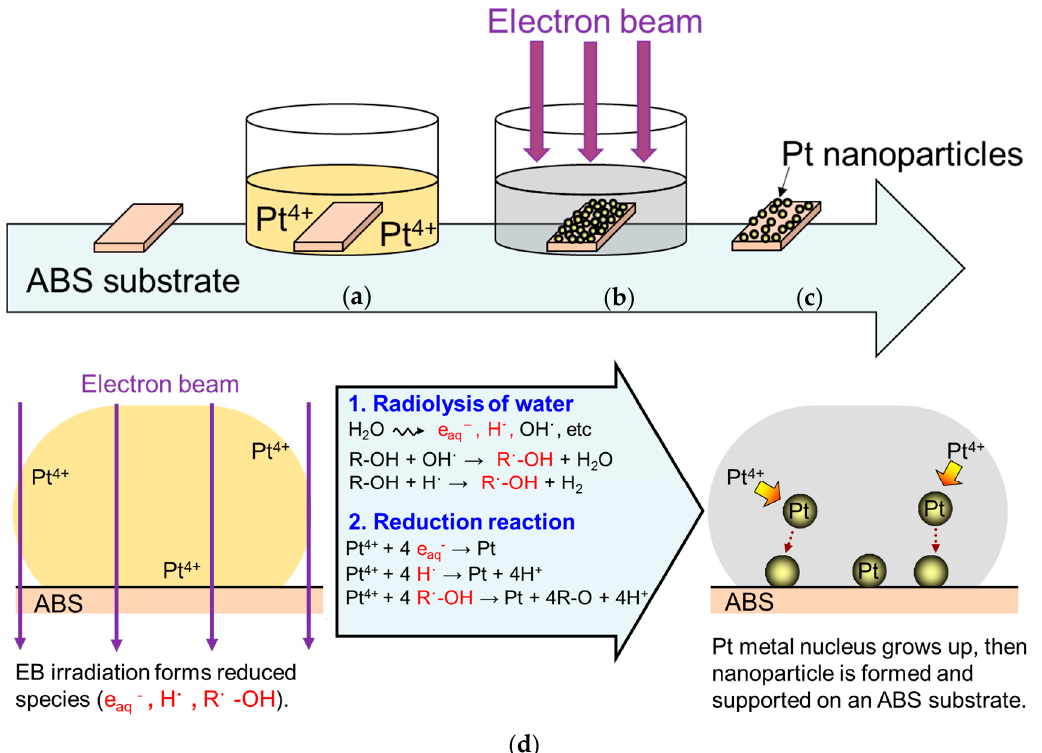
Figure 8. Schematic of the process for preparing a Pt-particle/ABS sample using an EBIRM: ( a ) Immersion of the ABS substrate in Pt precursor solution; ( b ) Irradiation by electron beam; ( c ) Removing it from the solution and drying using an N 2 gun; and ( d ) Radiolytic synthesis of ABS-supported Pt nanoparticles in detail.